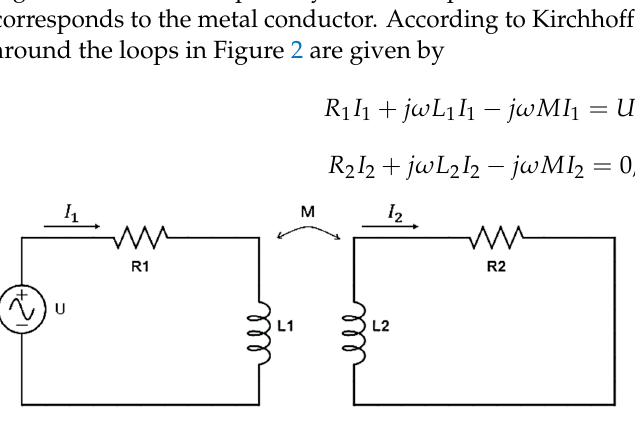
Figure 2. Equivalent circuit model of EC displacement sensor.